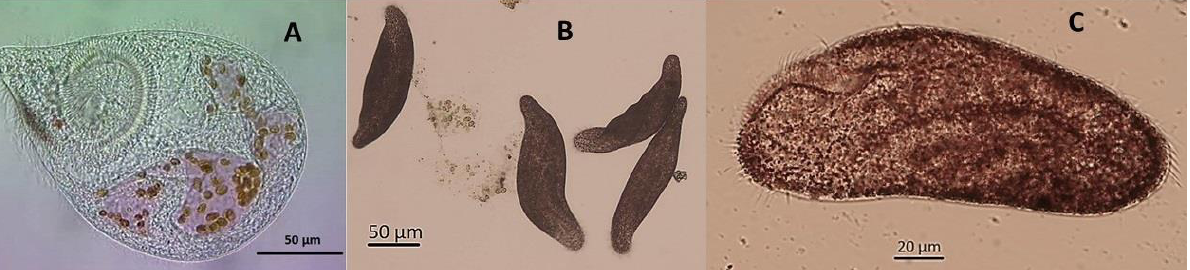
Figure 1. Microphotographs of ( A ) Fabrea salina and ( B , C ) Condylostoma sp. (at different magifications) used in the experimentation. Inside F. salina many digestive vacuoles are prominent, filled with partly digested cells of Rhodomonas salina that have released their saps, imparting reddish coloration on the vacuoles. This particular strain of Condylostoma had a characteristic orange-brownish coloration that made it almost impossible to discern cell details.